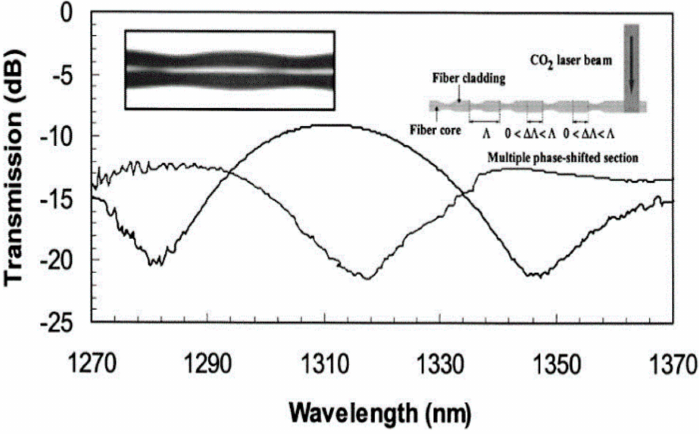
Figure 28. Transmission spectra of the LPG with (solid curve) and without (gray curve) the p-phase- shift at the grating center. Insets, (left) microphotography of the PS-LPG surface and (right) schematic diagram for formation of the PS-LPG. Adapted with permission from ref. [155]. © The Optical